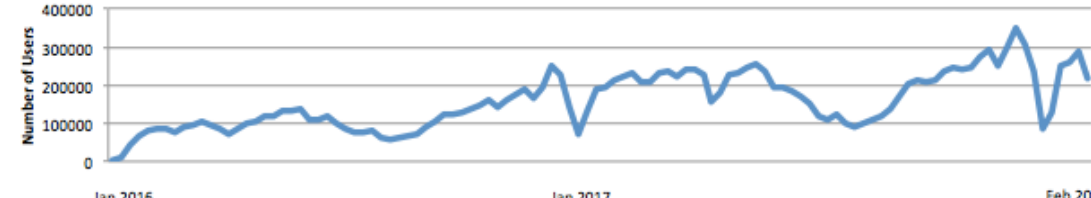
Figure 5. This line-graph shows weekly ScratchJr